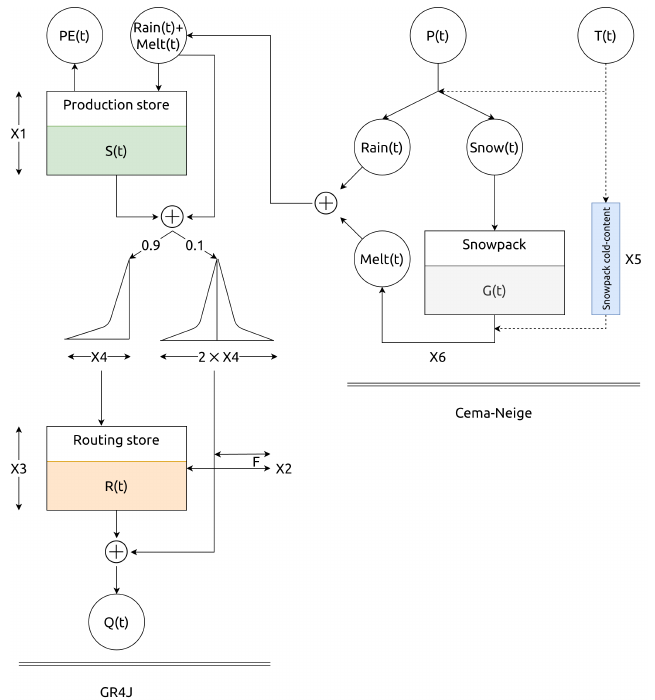
Figure 2. GR4J hydrological model